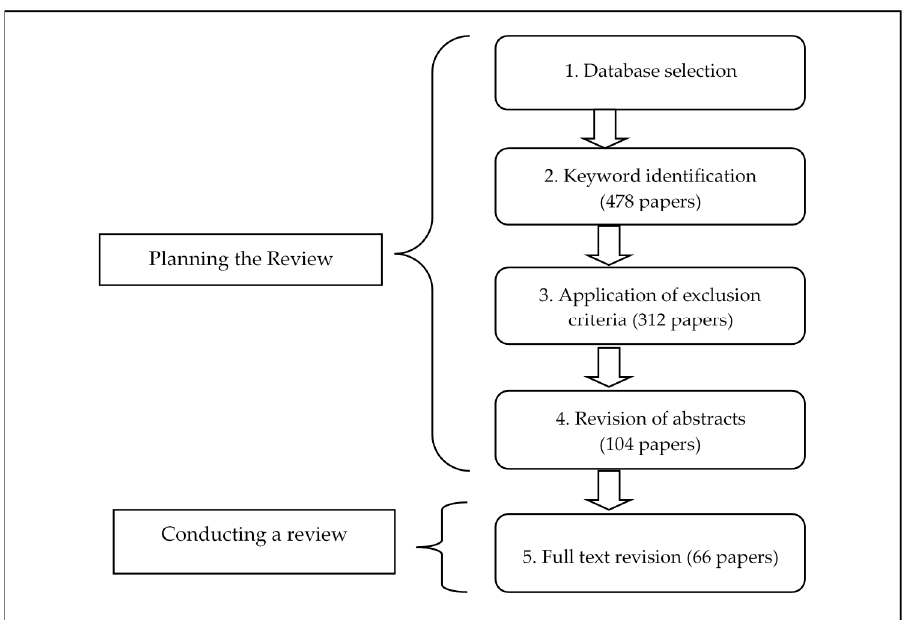
Figure 2. Systematic review process.